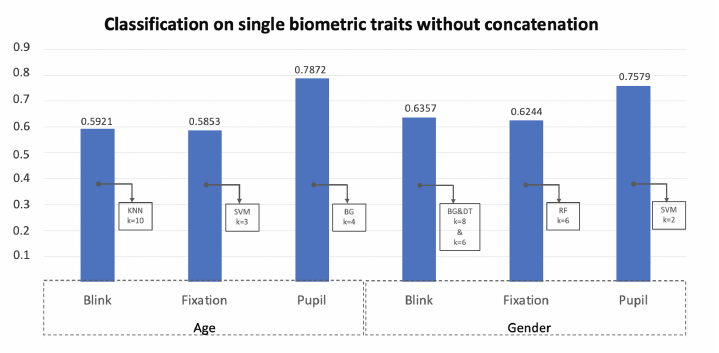
Figure 8. The results of the best classifiers on single biometric traits. k is the value of the implemented k-fold cross-validation strategy relating to the best accuracy achieved. Exploiting only the blink for gender classification there are two classifiers that report the same higher